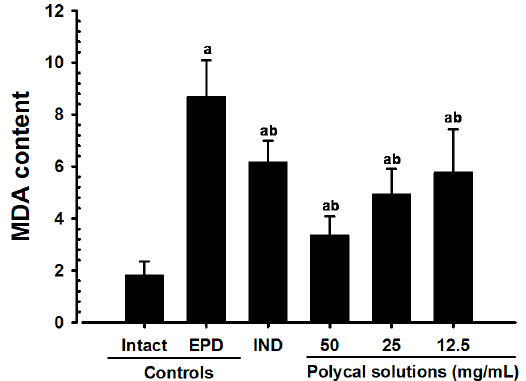
Figure 7. Gingival MDA levels in Intact or EPD Rats. Values are expressed mean ± S.D. of eight rats, μ M/mg tissue. EPD = experimental periodontal diseases induced by ligature placement around the cervix of upper left incisor teeth; Polycal = Polycan and calcium gluconate 2:98 (g/g) mixture, which was topically applied to ligated gingival regions, once a day for 10 days (200 μ L/rats). IND = Indomethacin, which was orally administered at 5 mg/kg dose level, once a day for 10 days; MDA = Malondialdehyde. a p < 0.01 as compared with Intact control; b p < 0.01 as compared with EPD control.